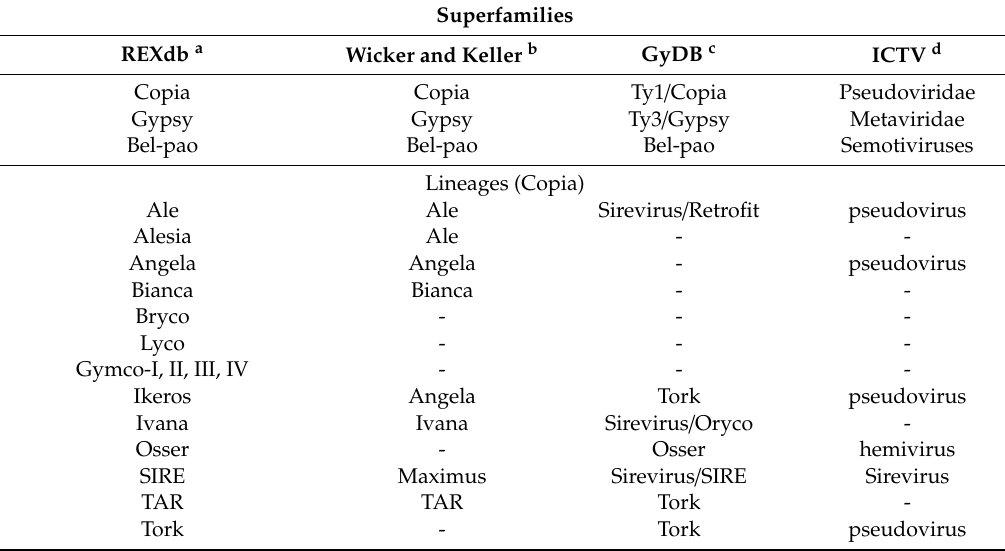
Figure 6. Classification of TEs following Rexdb and GyDB nomenclature. Adapted from [26]. Table 3. Correspondences between names of superfamilies and lineages given for some classification systems and the International Committee on Taxonomy of Viruses (ICTV). Adapted from